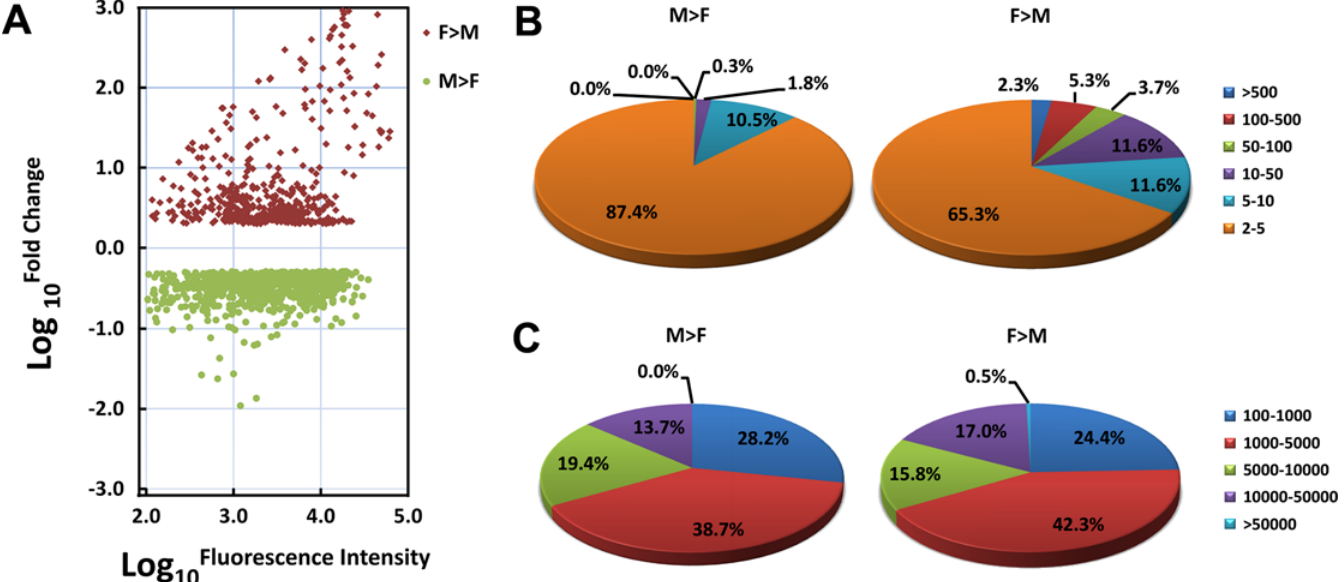
Fig 2. Bias ratio and signal intensity analysis of gender-biased expressed genes. A . Scatter plot showing the distribution of the bias ratio for adult male and female-associated genes. The Y-axis corresponds to a log 10 fold change between adult male and female worms and the X-axis corresponds to the log 10 fluorescence intensity (enriched in males — green or in females red); B. Percentage of genes showing different fluorescence intensities; C. Percentage of genes showing different bias